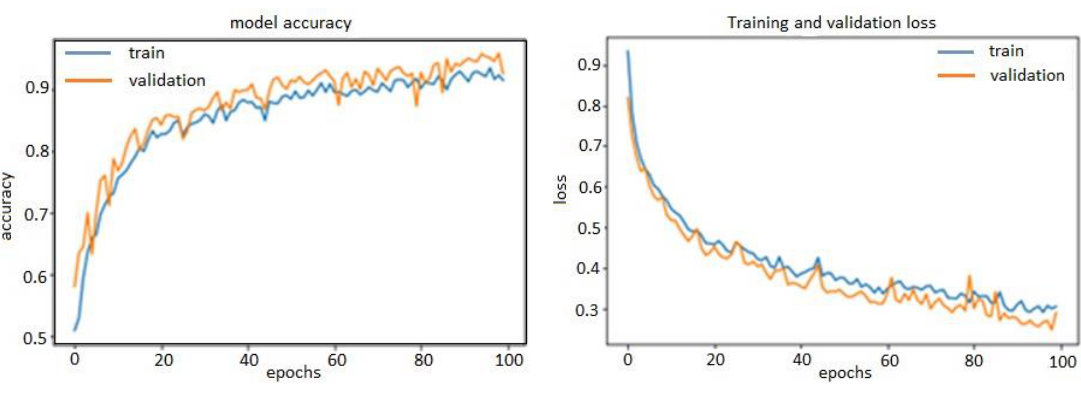
Figure 14. Accuracy and loss model of time-domain features_1D-CNN. Figure 15. Accuracy and loss model of Wavelet_1D-CNN. In this model, we used adaptive moment estimation (Adam) as the main efficient optimization algorithm to update network weights iteratively based on training data. Adam has superiority compared with the other optimizers; it is straightforward to implement, computationally efficient, has few memory requirements, is invariant to diagonal rescale of the gradients, is well suited for problems that are large in terms of data and/or parameters, is appropriate for non-stationary objectives as well as for problems with very noisy/or sparse gradients, and hyper-parameters have intuitive interpretation and typically require little tuning. We also needed to specify the loss function to evaluate a set of weights. In this case, we used logarithmic loss, which is defined in Keras as binary cross-entropy for a binary classification problem.